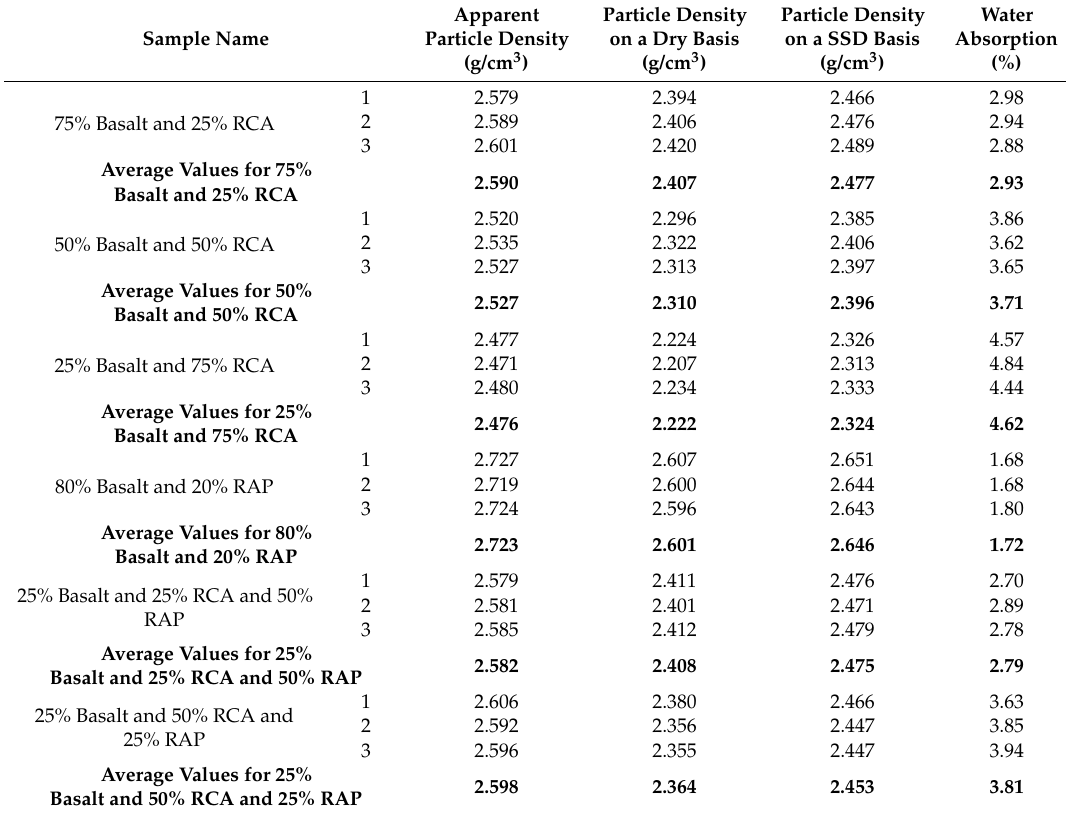
Table 5. The Results of Particle Density and Water Absorption Test for the Mix of Coarse Aggregates.